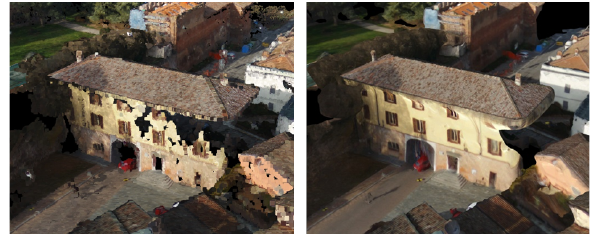
Figure 5. Square flight, point cloud (left) and mesh (right) RMS of the GCPs errors is equal to 0.011m while the projection error have RMS of 1.261 pixels. The rectangular flight has been performed with a double grid plan and rectangular geometry. 53